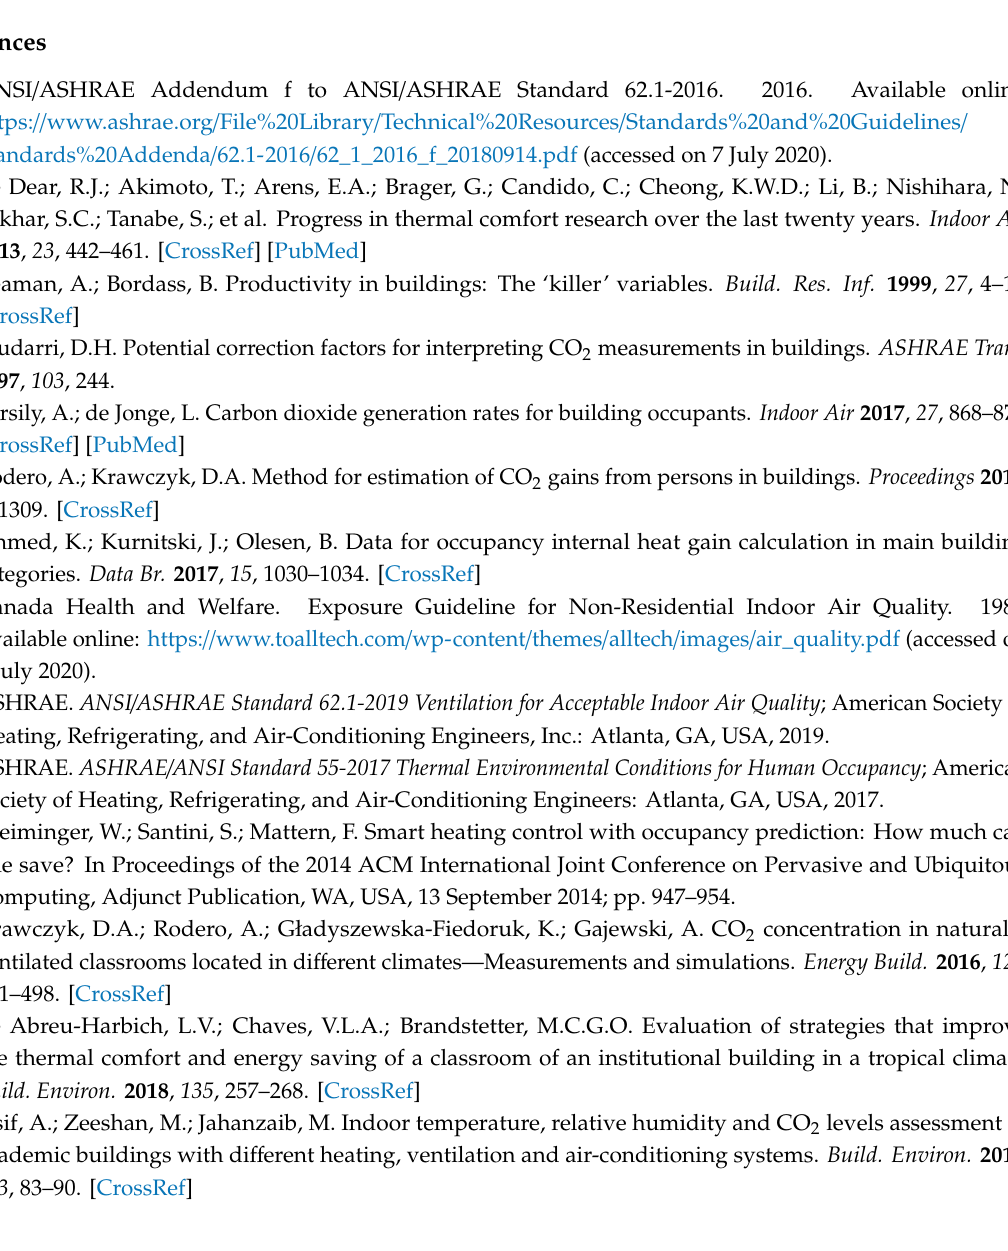
Figure A10. Friday Occupancy Pattern (input to BES).